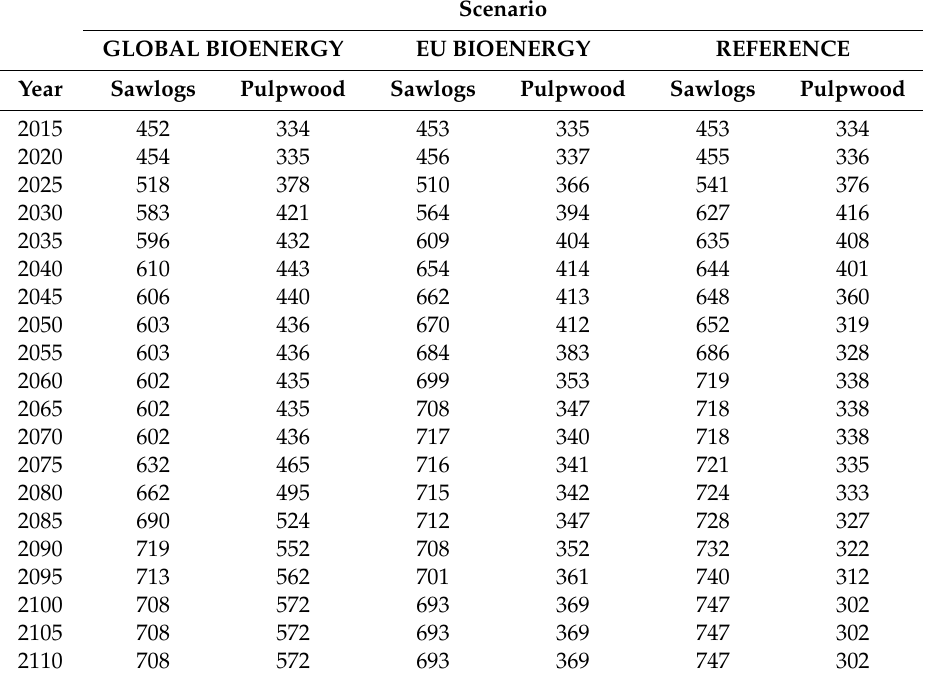
Table 5. Prices SEK per m 3 under bark for sawlogs and